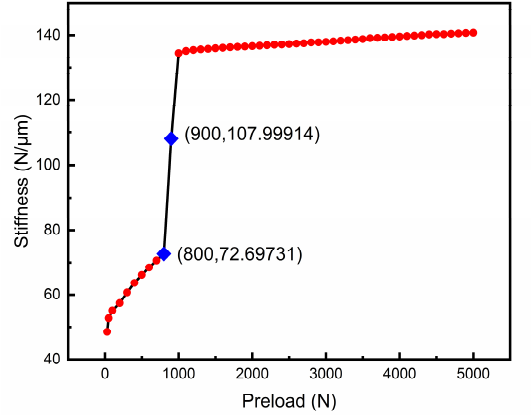
Figure 10. The relation curve between axial stiffness and preload of spindle.